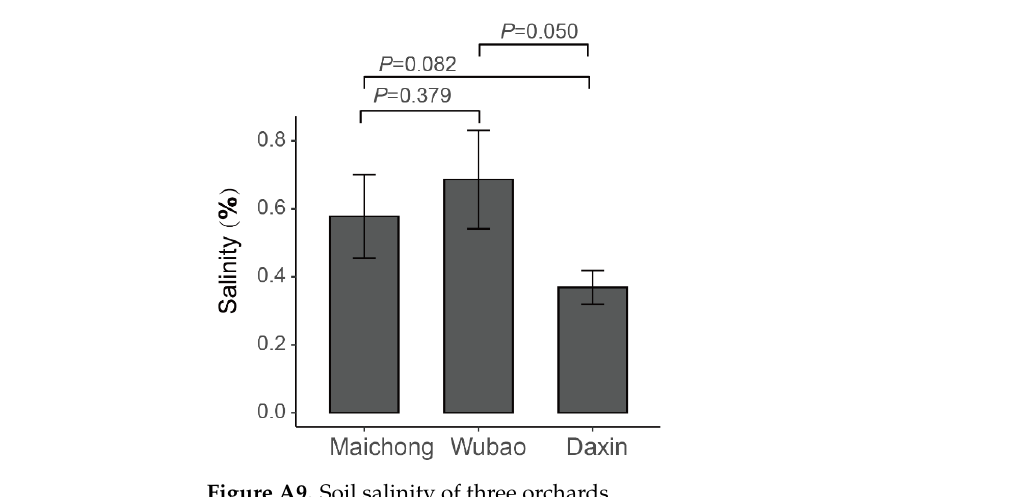
Figure A9. Soil salinity of three orchards.